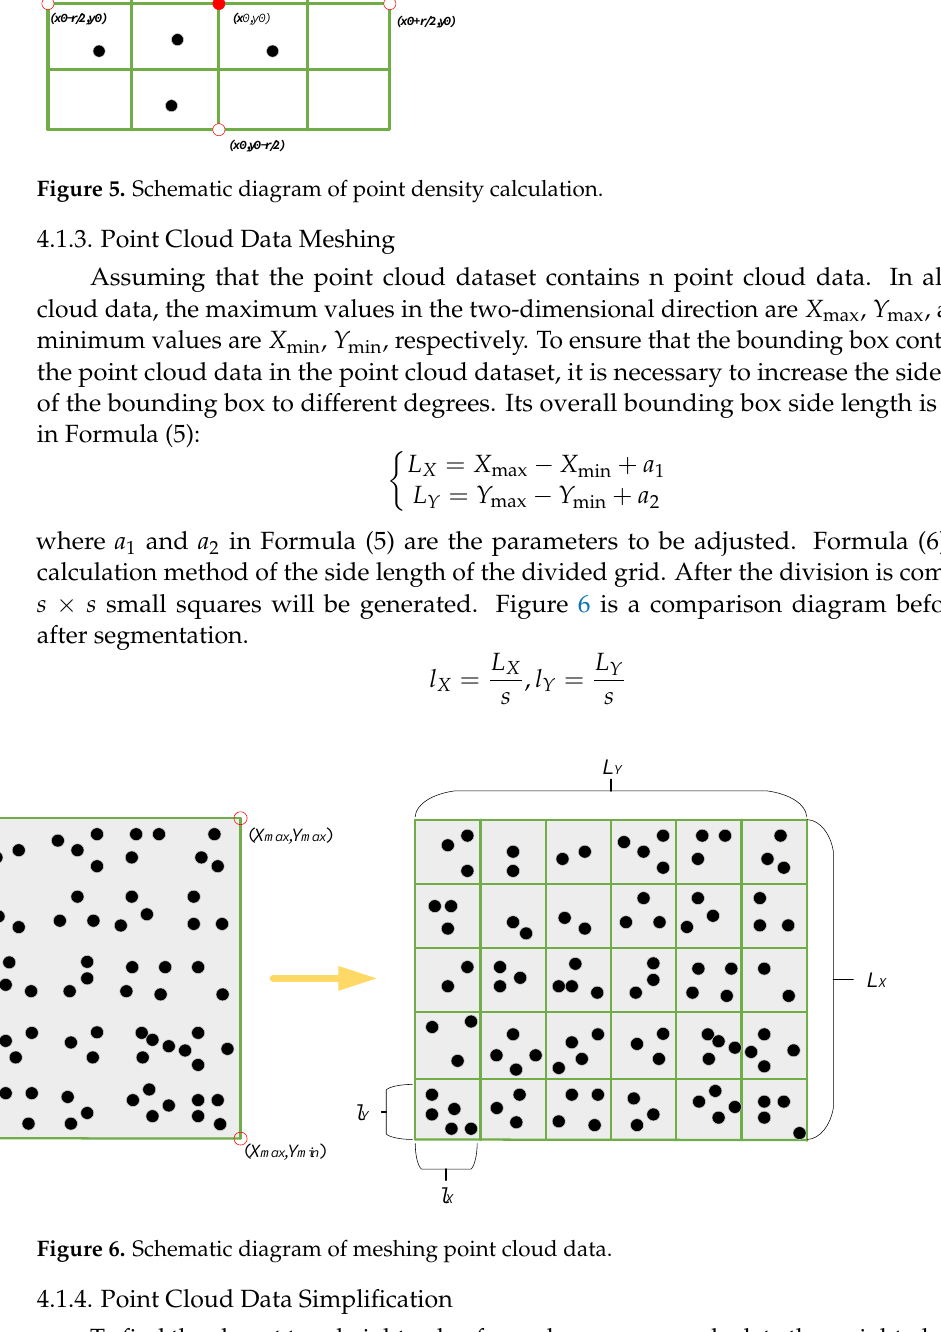
Figure 7. Simplified schematic diagram of point cloud data. The pseudo code of the algorithm proposed in this paper is shown in Algorithm 1. Algorithm 1 PDS(P,s,r) Input : Point cloud data P, Grid number s Density range r Output : newP 1: P = Coordinate translation (P) 2: Pdensity = Computing density (P, r) 3: P = Mesh(P, s)